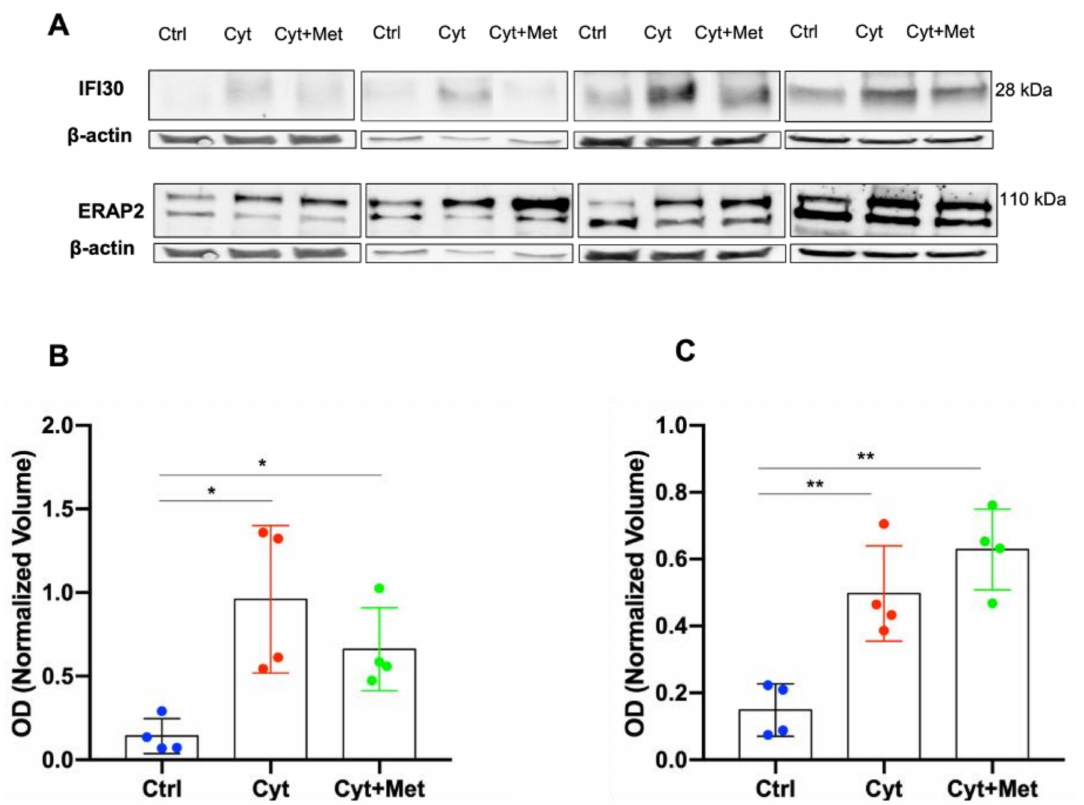
Figure 6. Western blot (WB) analysis was used to evaluate the expression of IFI30 and ERAP2, in both cytokines and cytokines + metformin treated islets compared to control samples. ( A ) Immunore- active bands of IFI30 (28KDa), ERAP2 (110KDa), and β -actin, as observed in four independent islet preparations in the three different conditions. ( B , C ) Violin plots of the normalized OD, reported as mean values ± SEM, for IFI30 (panel B ) and ERAP2 (panel C ). The dashed line represents the median values, and the dot lines represent the first and the third quartiles. Statistical analysis was performed using a parametric paired t test. * p < 0.05, ** p <